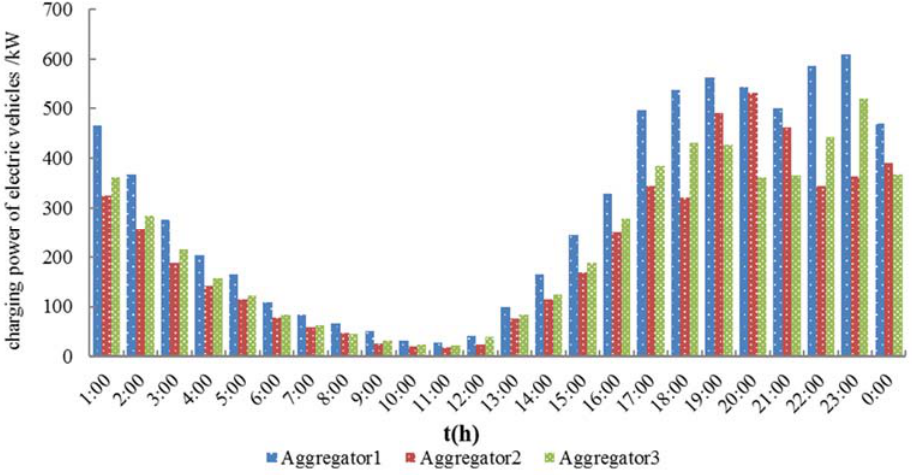
Figure 4. Charging power distribution of each aggregator after adjustment for charging fees.